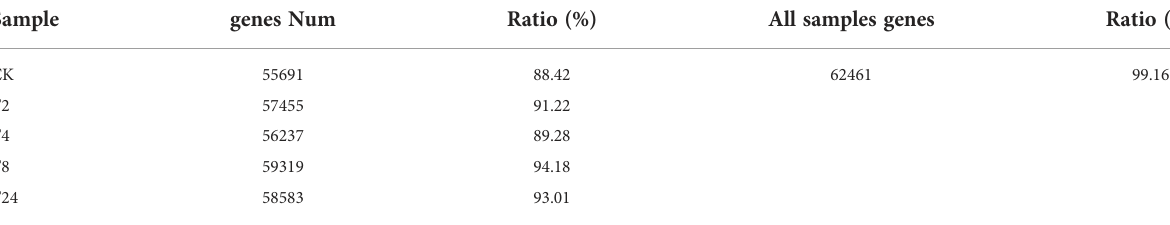
TABLE 3 Genes expression statistics of each sample (total reference genes